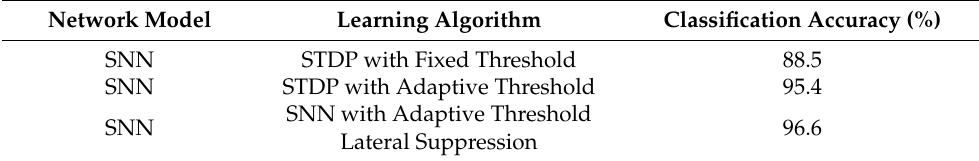
Table 4. Algorithm Comparison. Network Model